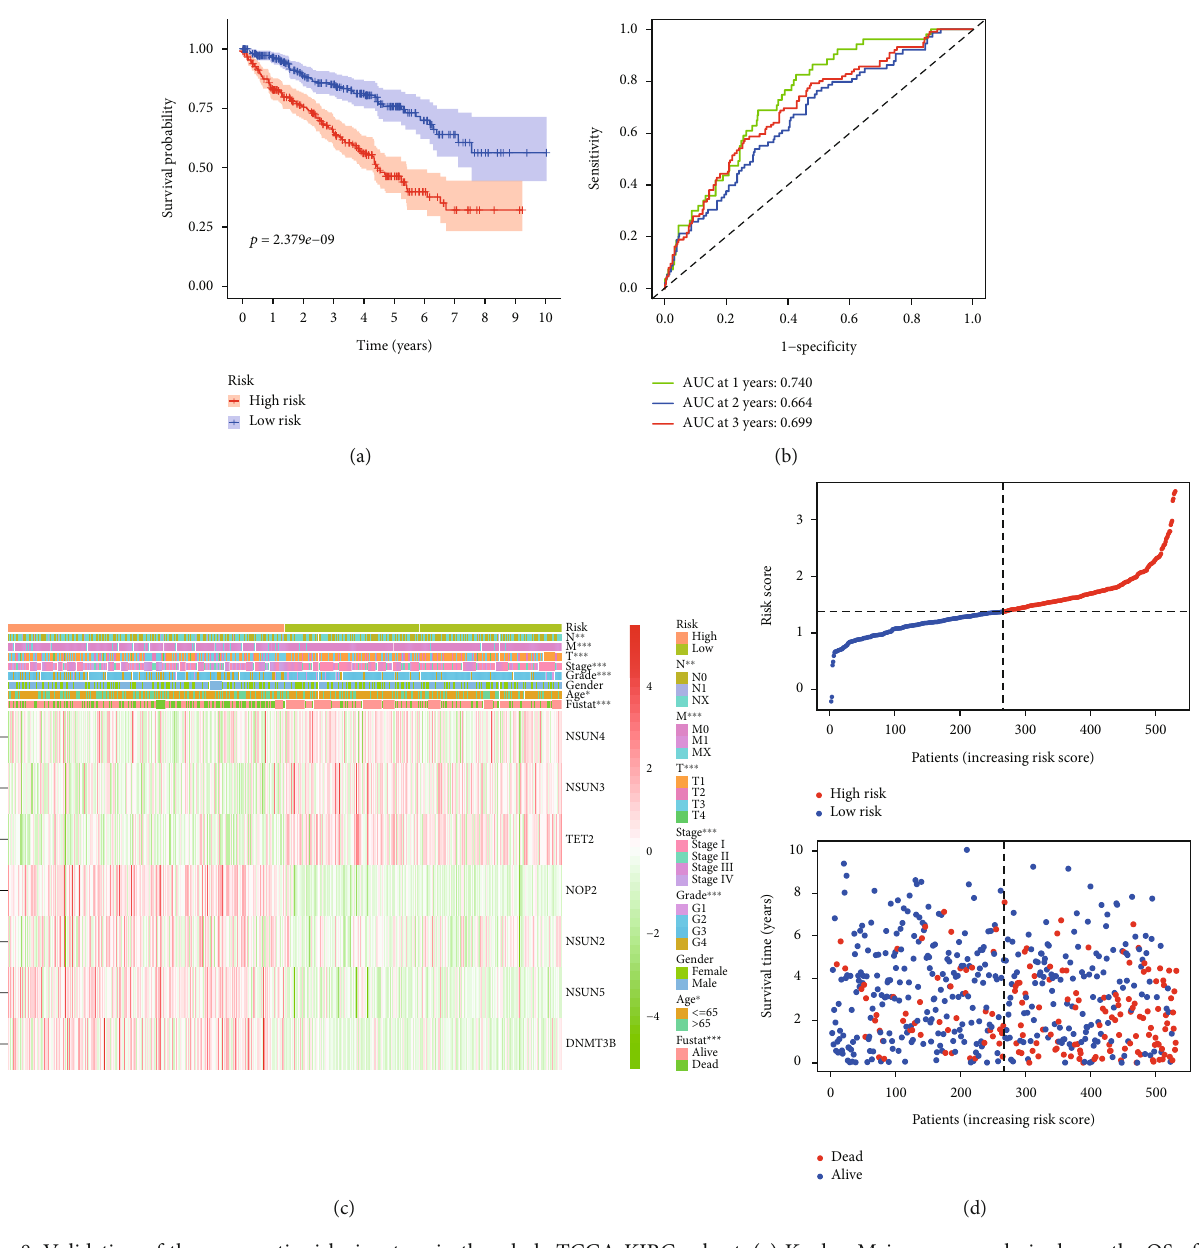
Figure 8: Validation of the prognostic risk signature in the whole TCGA-KIRC cohort. (a) Kaplan-Meier curve analysis shows the OS of high-risk ( n = 258 ) and low-risk ( n = 259 ) ccRCC patients in the entire TCGA cohort. (b) ROC curve analysis in the entire cohort shows the false positive rate vs. true positive rate plots based on the prognostic risk signature. The AUC values for 1-year (green), 2-year (blue), and 3-year (red) survival rates are also shown. (c) The expression heatmap of the seven prognostic-risk related m 5 C RNA methylation regulators in the high-risk (blue) and low-risk (pink) ccRCC patients of the entire cohort. ∗∗ p < 0 : 01 ; ∗∗∗ p < 0 : 001 . (d) The distributions of risk scores of the high-risk (red) and low-risk (blue) ccRCC patients and corresponding survival time (the red dots represent the dead patients and the blue dots represent the alive patients) in the entire